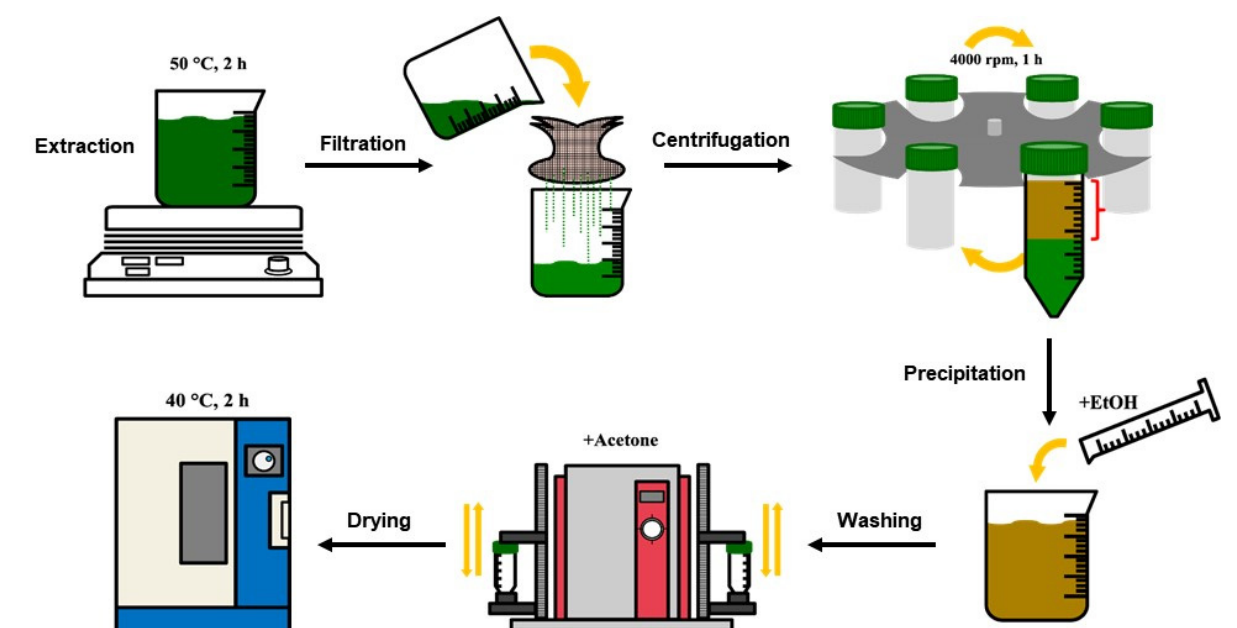
Figure 1. Extraction process of C. olitorius mucilage.